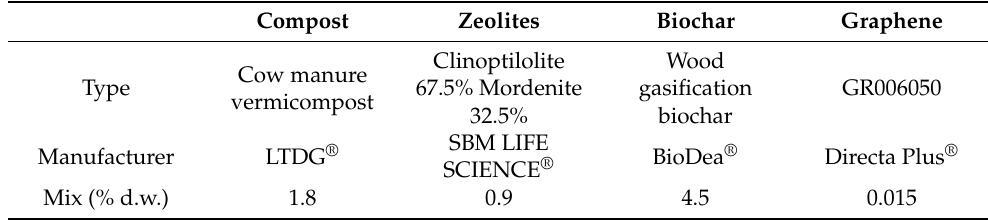
Table 2. Type of soil improvers used in this study and their percentage in the batch experiments (as dry